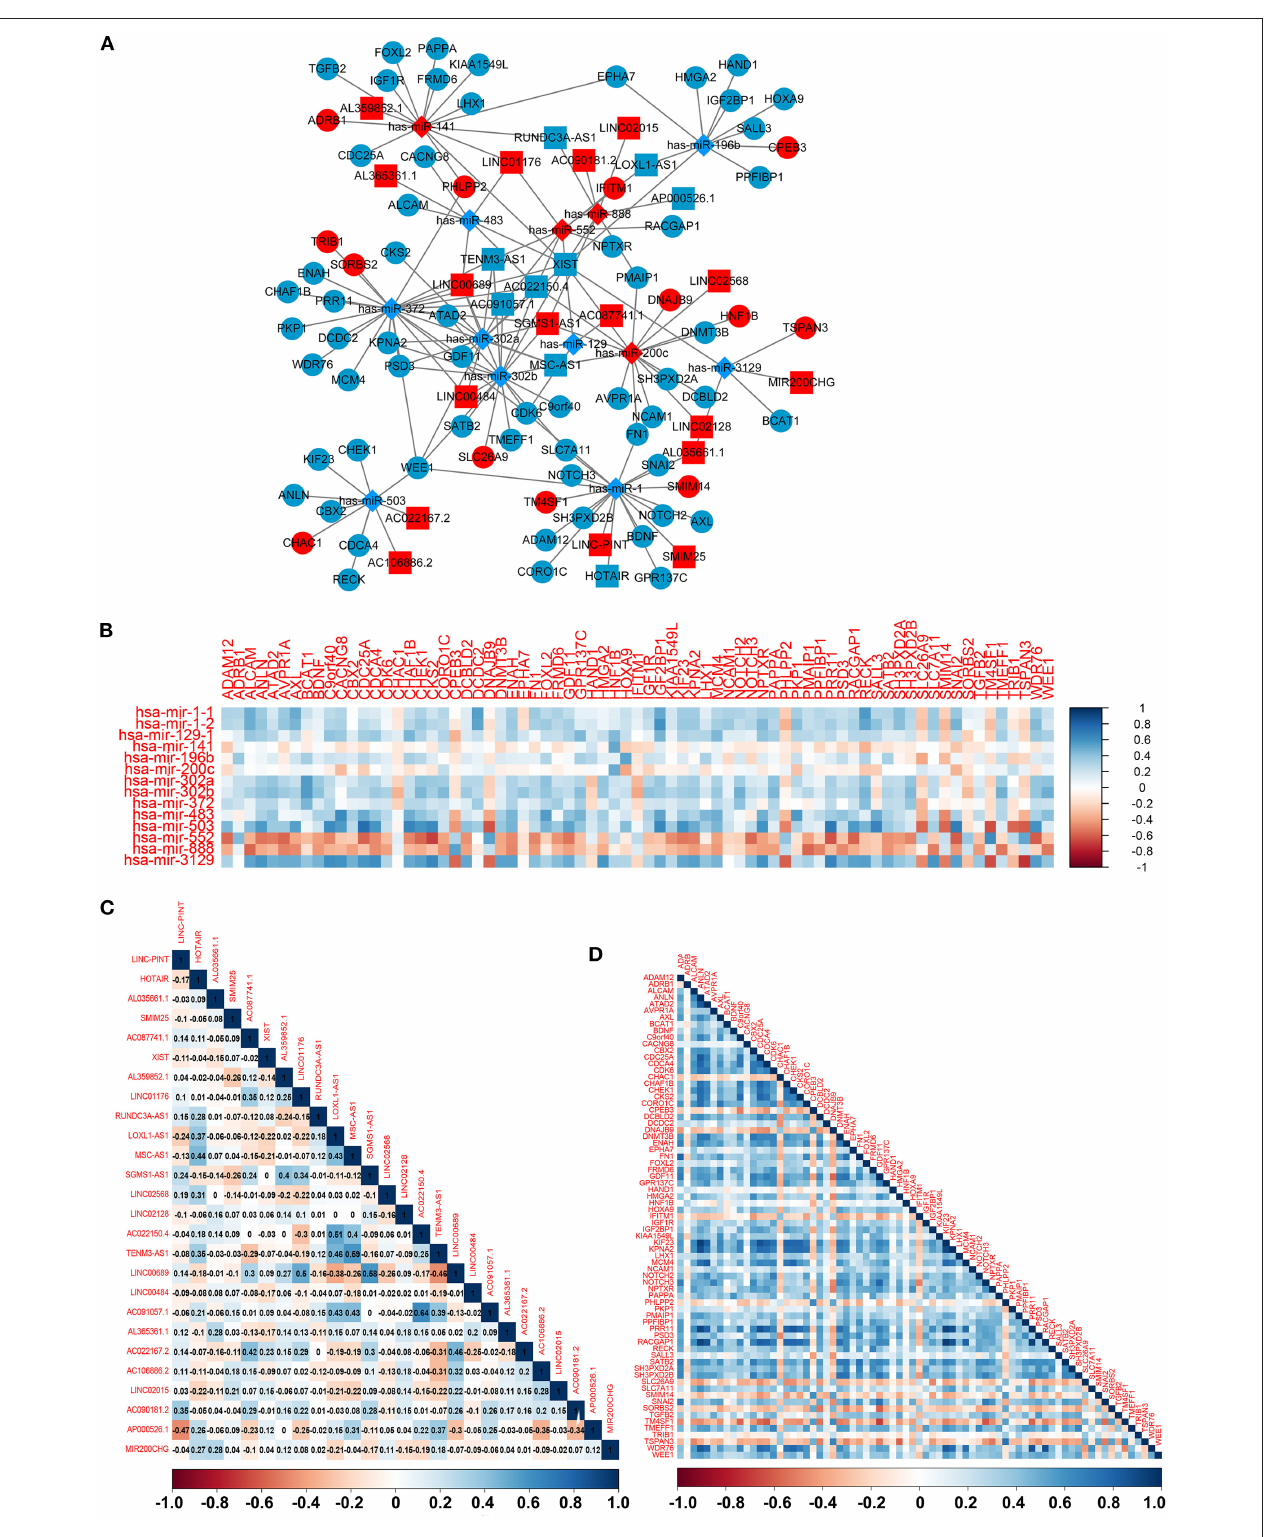
FIGURE 4 | The construction of the ceRNA network among the 26 lncRNAs, 13 miRNAs, and 73 mRNAs. (A) The ceRNA network among lncRNA–miRNA–mRNA. Ellipse represents mRNA. Rectangle represents lncRNA. Diamond represents miRNA. Red represents upregulation, and blue represents downregulation. (B–D) The Pearson correlation analyses among the miRNA–mRNA, 26 lncRNAs, and 73 mRNAs.